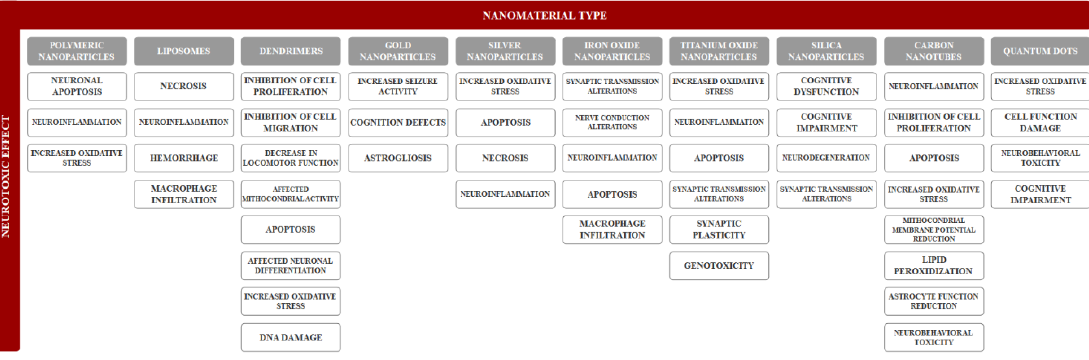
Figure 2. A summary of nanomaterial-induced neurotoxic effects.